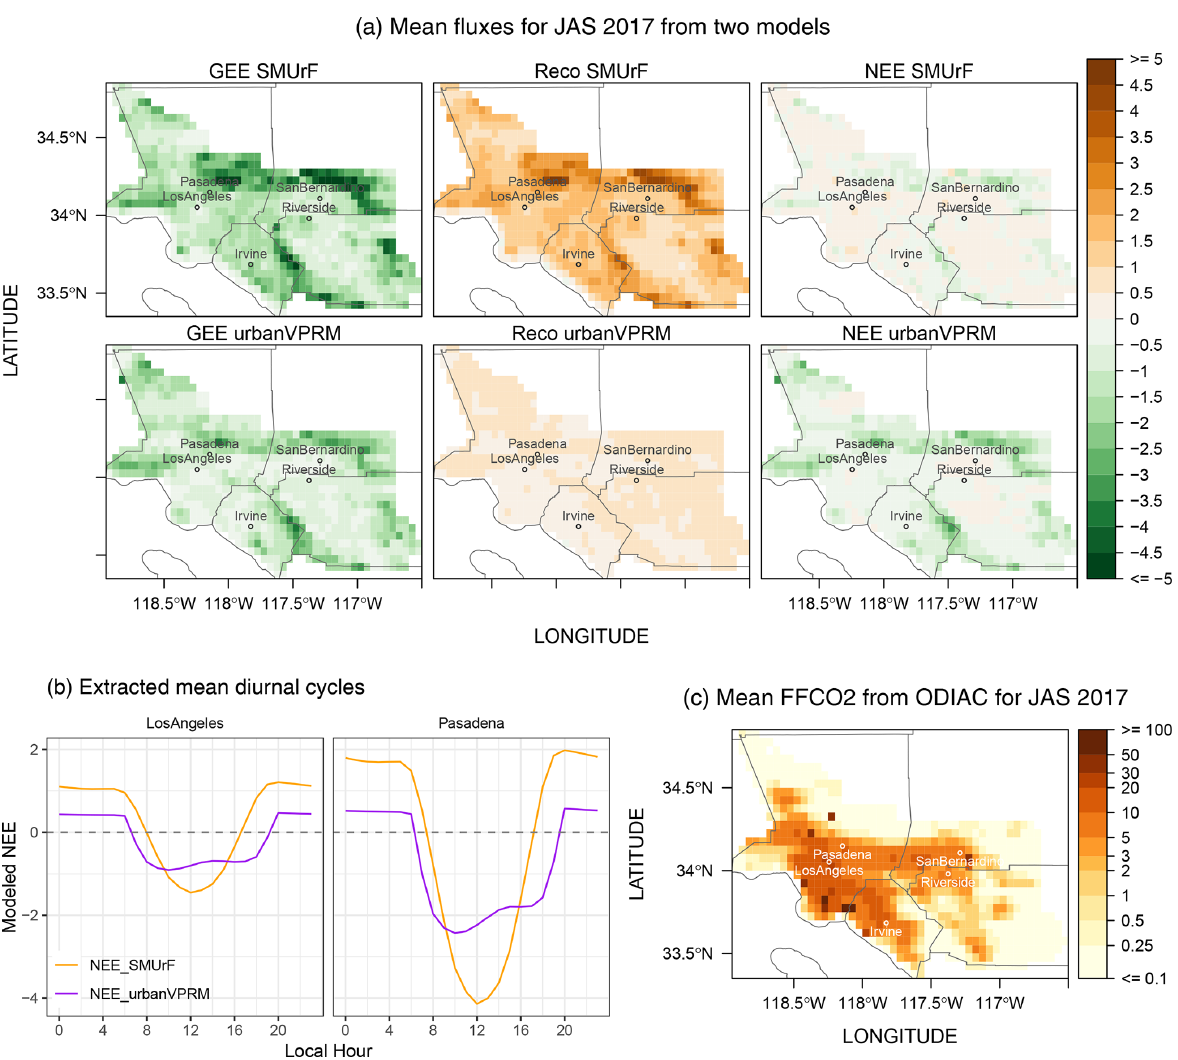
Figure 11. (a) Spatial maps of mean GEE, R eco , and NEE fluxes [µmolm − 2 s − 1 ] from SMUrF and urbanVPRM over the greater Los Angeles region from July to September (JAS) in 2017. (b) Mean diurnal cycles of NEE fluxes over JAS 2017 between the two models. (c) Map of mean FFCO 2 [µmolm − 2 s − 1 ] at 0.05 ◦ aggregated from the 1km ODIAC product over JAS 2017. Main cities have been labeled on the maps including Los Angeles, Pasadena, Irvine, Riverside, and San